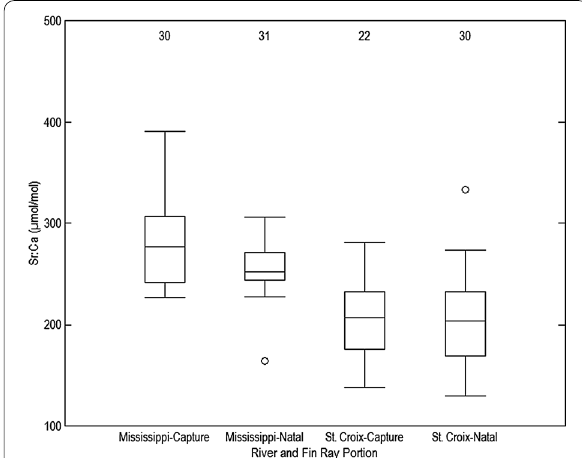
Fig. 9 Boxplots illustrating the distributions of strontium (Sr) to calcium (Ca) ratios measured in natal and capture location portions of pectoral fin rays from lake sturgeon captured in the Mississippi and St. Croix Rivers. Numerals above the boxes represent the number of lake sturgeon sampled for each combination of river and fin ray portion. Boxes represent interquartile ranges, with center lines in representing median values and the upper and lower ends of the boxes representing the 75th and 25th percentiles, respectively. Whiskers represent values within 1.5 times of the interquartile range, either above the 75th percentile or below the 25th percentile. Data points plotted as open circles represent values within 3 times the interquartile